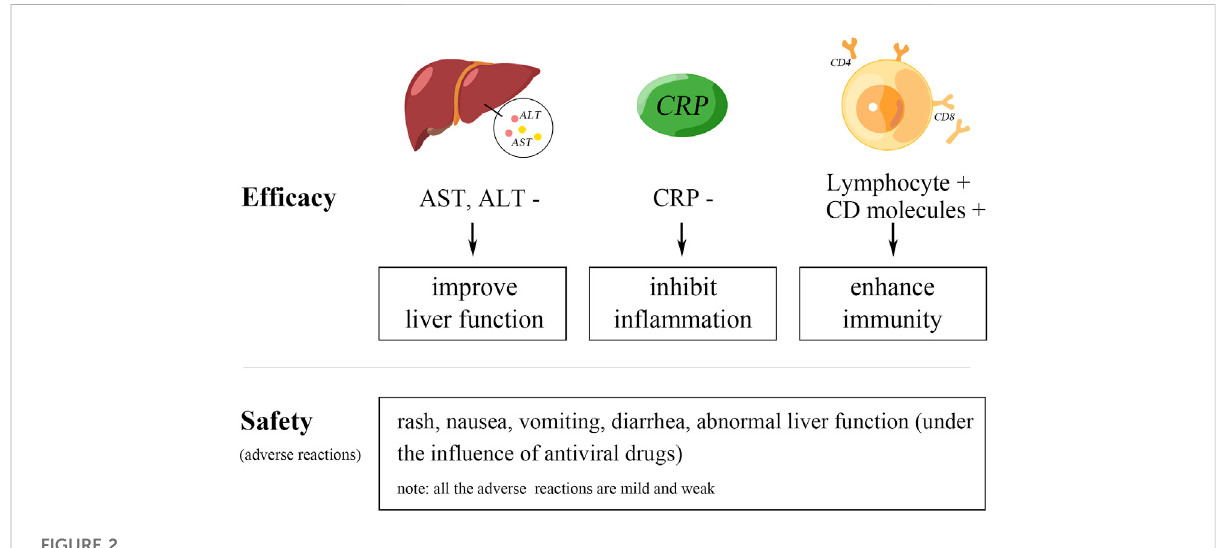
FIGURE 2 Schematic diagram of the